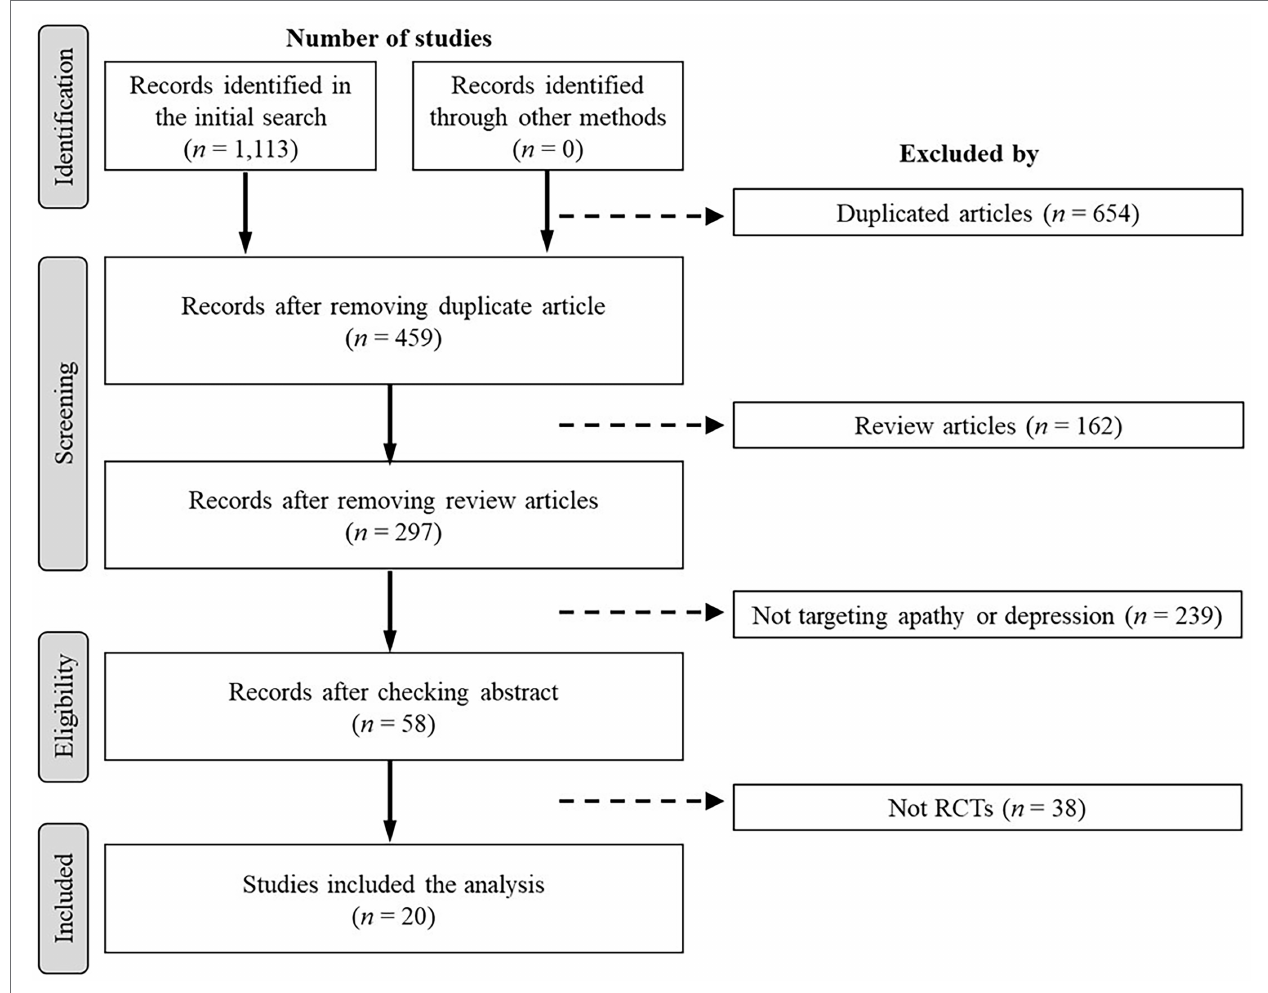
FIGURE 1 | Study flow